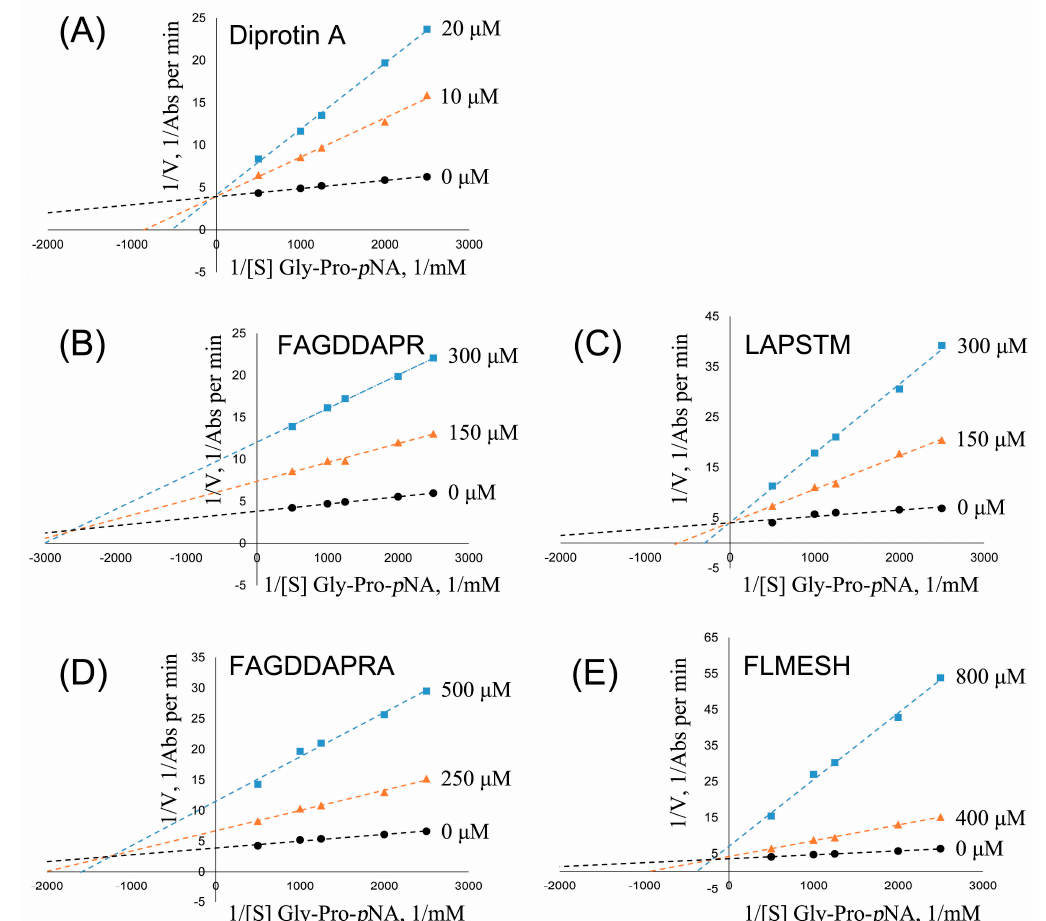
Figure 7. Lineweaver—Burk double-reciprocal plot for DPP-IV activity in the absence and presence of four peptides at different inhibitory concentrations. ( A ) Diprotin A (0, 10, and 20 μ M) as reference; ( B ) peptide FAGDDAPR (0, 150, and 300 μ M); ( C ) peptide LAPSTM (0, 150, and 300 μ M); ( D ) peptide FAGDDAPRA (0, 250, and 500 μ M); and ( E ) peptide FLMESH (0, 400, and 800 μ M).